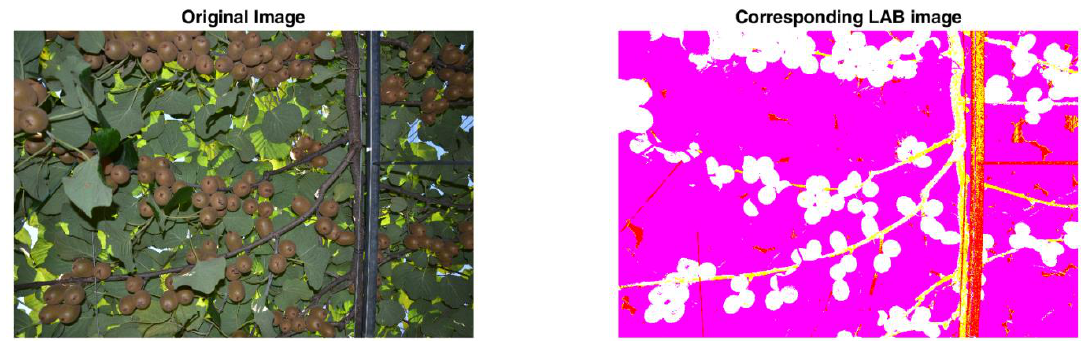
Figure 7. Example of an RGB image versus its respective LAB representation.